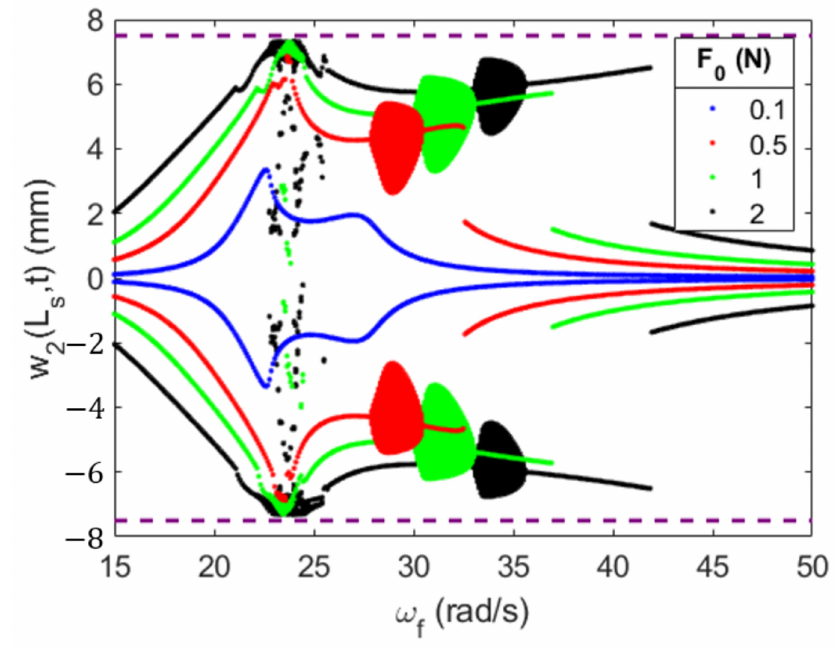
Figure A6. Bifurcation diagram of the absorber’s position with a gap of 7.5 mm, tip mass of 0.06 kg and a substrate thickness of 0.3638